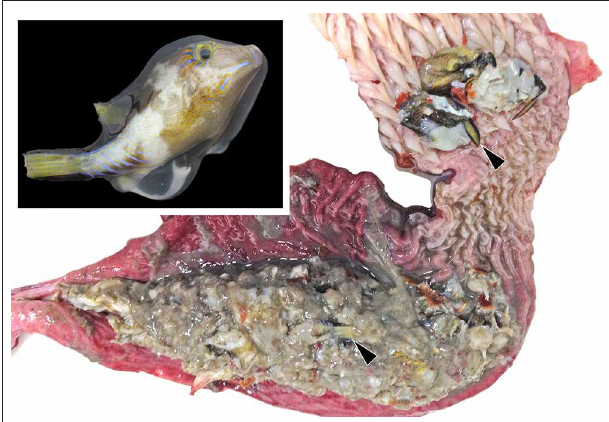
FIGURE 1 | The esophagus and stomach of a green turtle ( Chelonia mydas ) found dead during mass mortality of Atlantic sharpnose puffer fish ( Canthigaster rostrata , inset) on the Caribbean coast of Costa Rica in November 2013. The lumen is opened showing the remains of multiple puffers, the tails of which are recognizable (arrowheads).